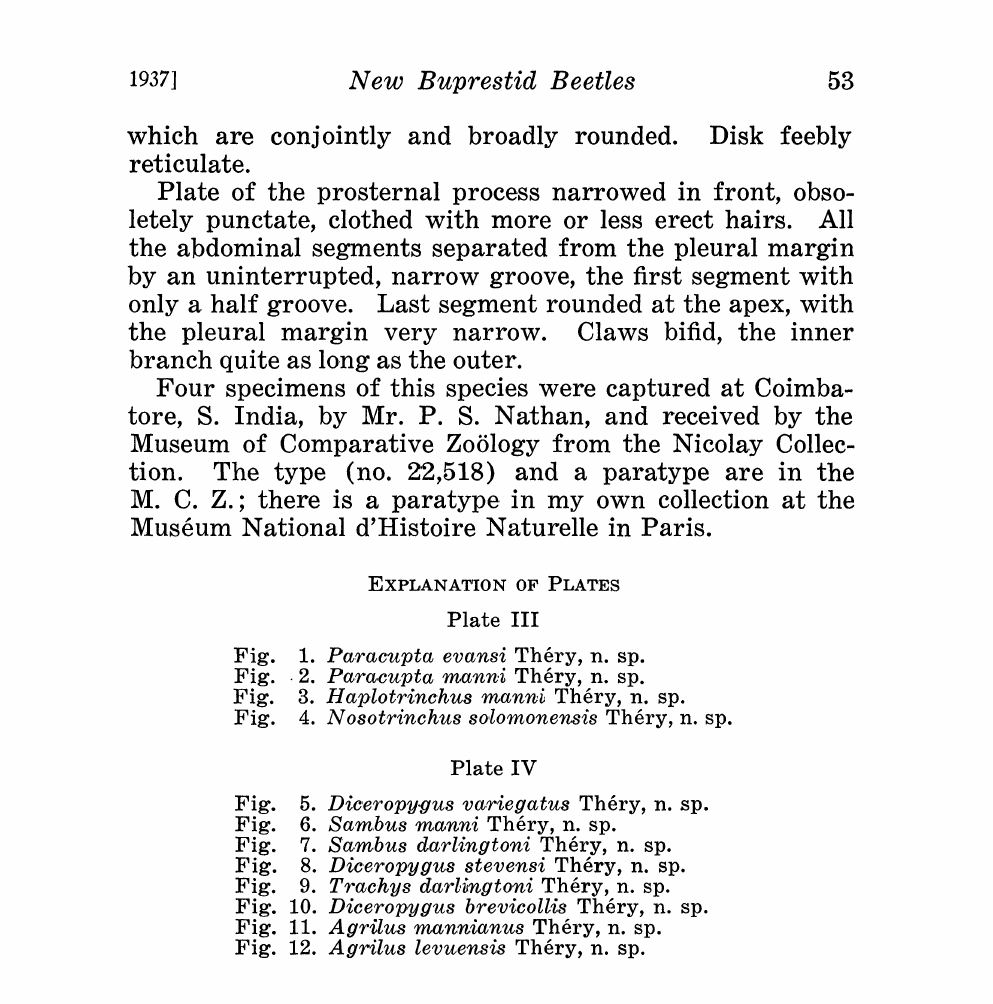
Fig. 5. Dic’eropygus va.riegatus Thry, n. sp. Fig. 6. Sambus mnni Thry, n. sp. Fig. 7. Sambus darlingtoni Thry, n. sp. Fig. 8. Diceropygus stevensi Thry, n. sp. Fig. 9. Tra.c.hys darl, ingtoni Thry, n. sp. Fig. 10. Diceropygus brevicollis Thry, n. sp. Fig. 11. Agrilus mannianus Thry, n. sp. Fig. 12. Agrilus levuensis Thry, n.